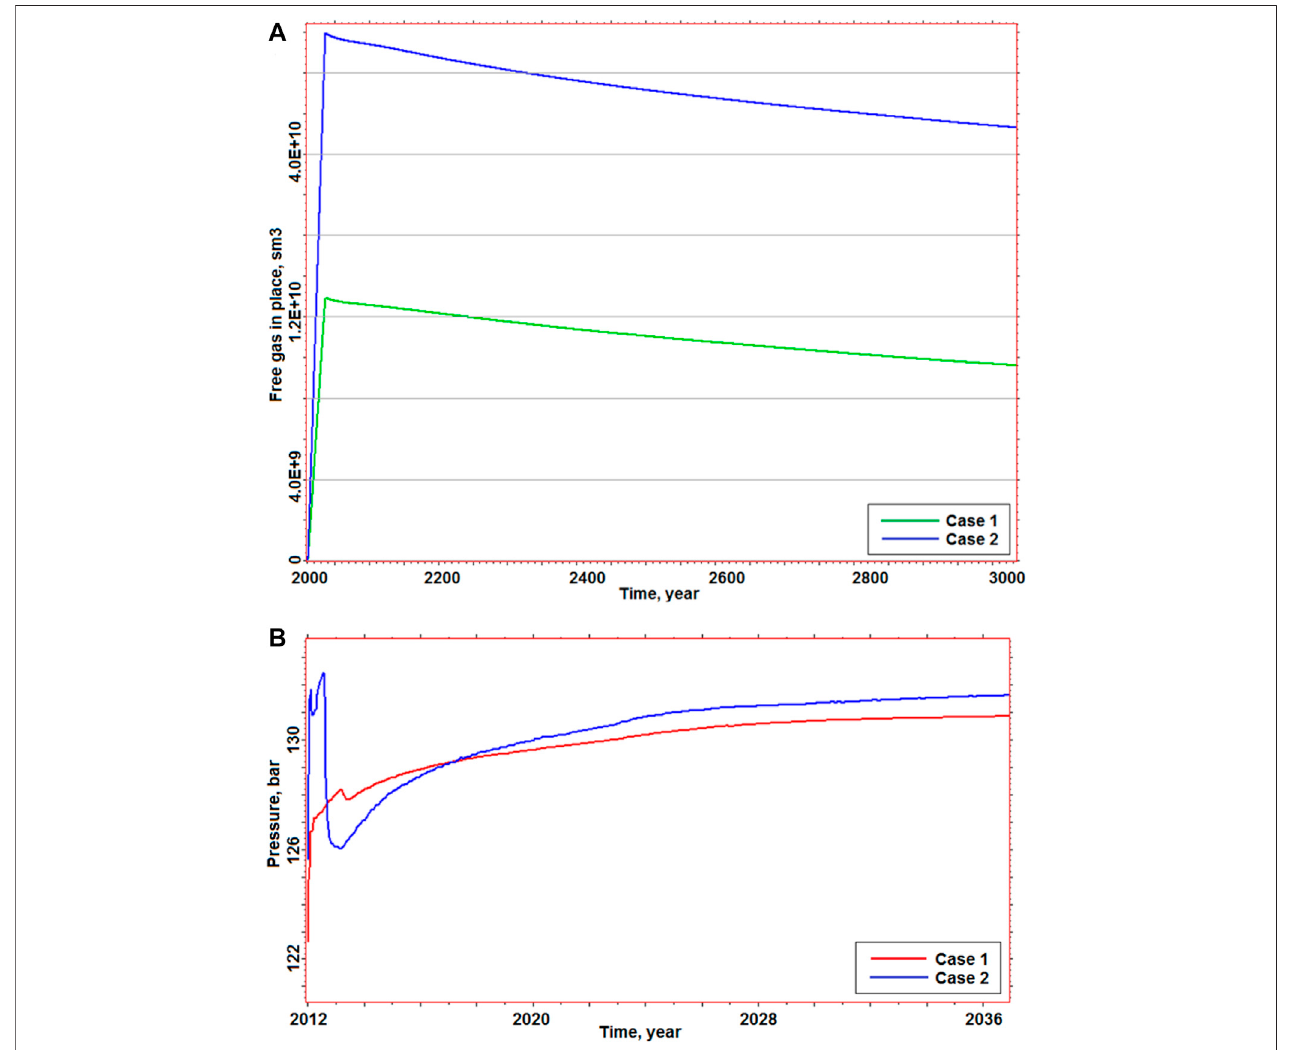
FIGURE 8 | Comparison of changes in the quantity of free CO 2 over time in the structure for Scenarios no. 1 and no. 2 in the (A) Suliszewo and (B) Choszczno-2 structures.